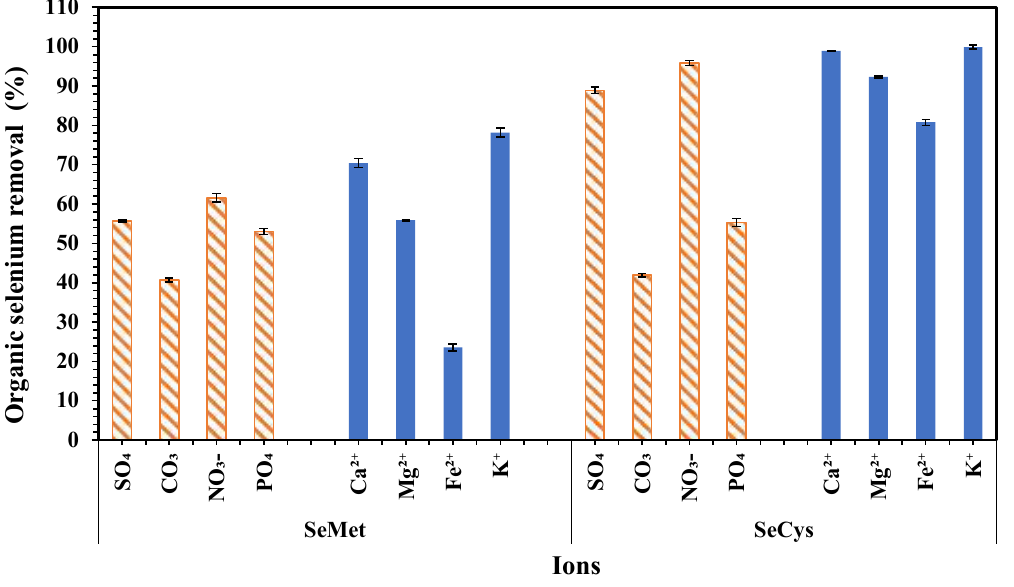
Figure 10. Effects of ions competing individually on organoselenium removal by nZVI/GAC with initial concentration of 0.5 mg/L, 3 g/L, pH 7.0 at 25 ◦ C. The concentration of ions in the solution is 100 mg/L and contact time of 24